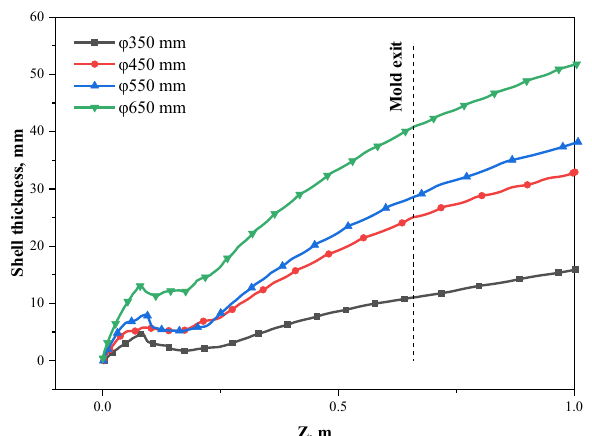
Figure 15. Shell thickness in the impact zone of the side port with different section sizes along the casting direction.